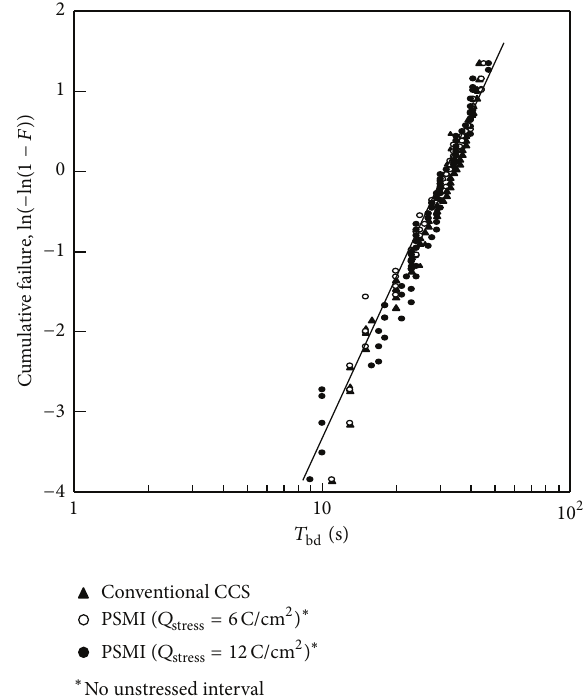
Figure 2: Distributions of 𝑇 for various stress conditions. Trian- bd distribution for the conventional CCS without any gles show the 𝑇 bd distributions unstressed interval . Open and closed circles show 𝑇 bd of 6 C/cm 2 and 𝑄 of 12 C/cm 2 with no for the PSMIs with 𝑄 stress stress unstressed interval,